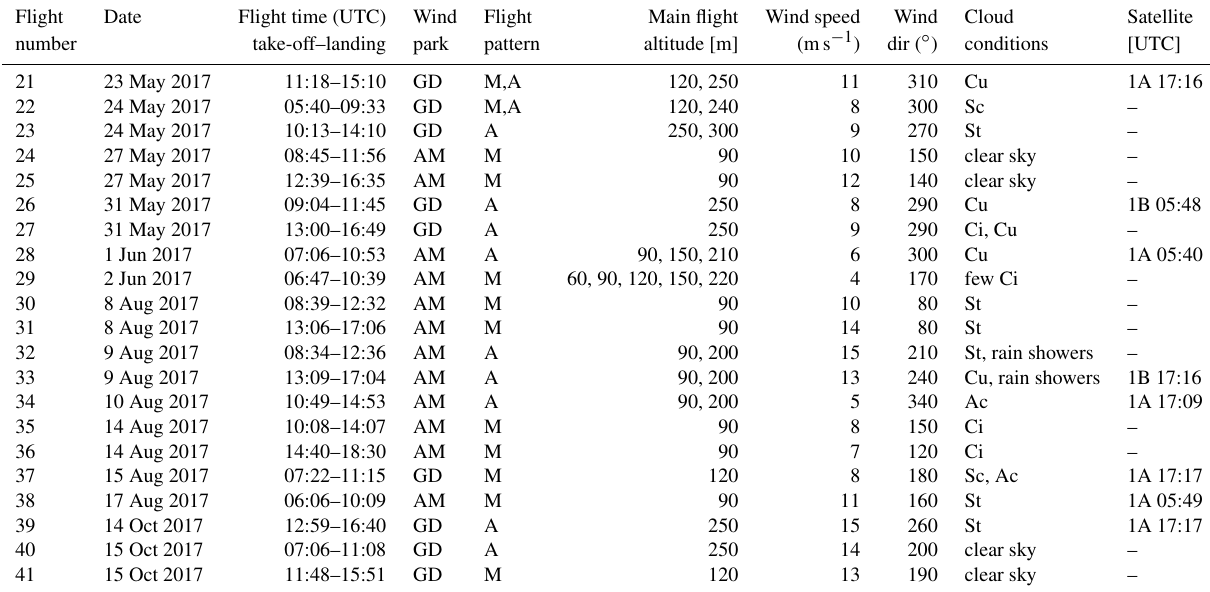
Table 2. Overview of the WIPAFF measurement flights 21–41 containing the same information as in Table 1. The same abbreviations are used in as in Table 1.